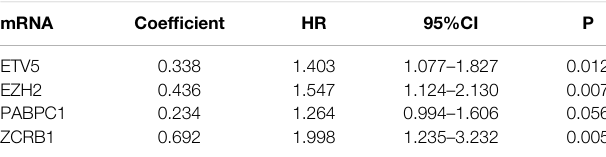
TABLE 2 | Each gene coef fi cients of the four-mRNA